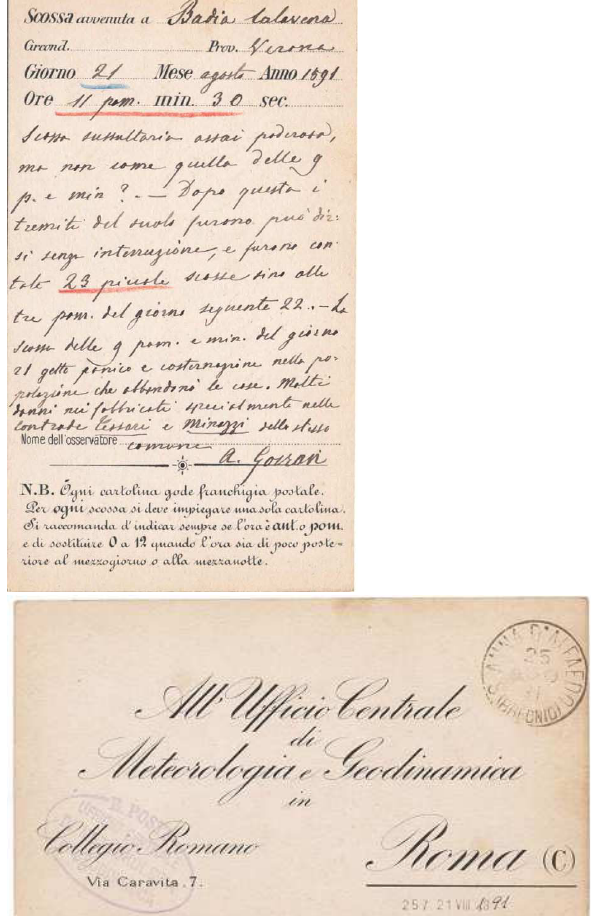
Fig. 5 Figure 5. Sample of a Seismic postcard. Front: to Central Of- fice for Meteorology and Geodynamics In Collegio Romano Via del Caravita, 7 Roma. Back: earthquake occurred at Badia Calavena District = Province Verona, Day 21, Month August, Year